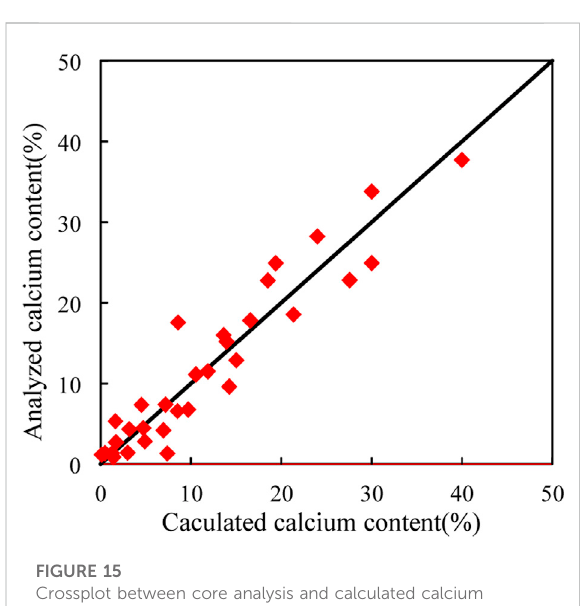
FIGURE 15 Crossplot between core analysis and calculated calcium